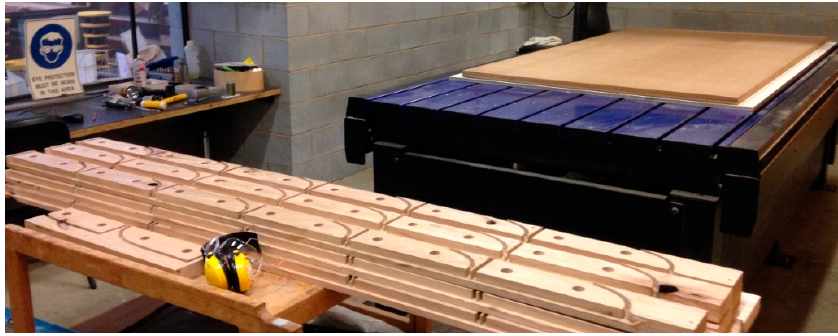
Figure 1. Six samples machined from individual boards.